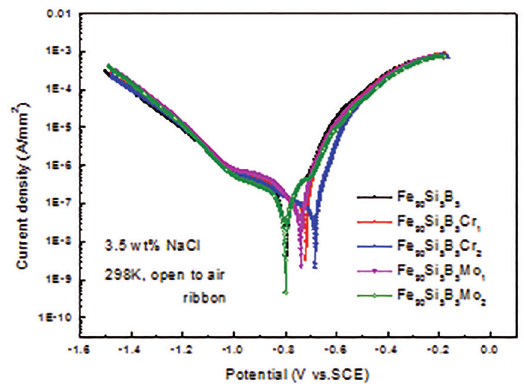
Si B M (M= Cr or Mo; 90-x 5 5 x